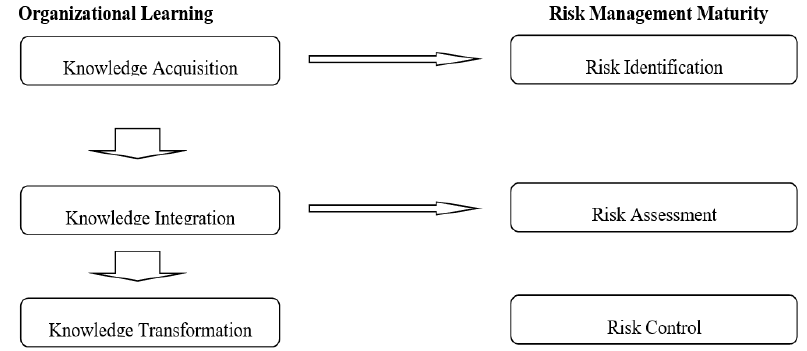
Figure 1. Conceptual Model Showing Relationship Between Organizational Learning and Risk Management